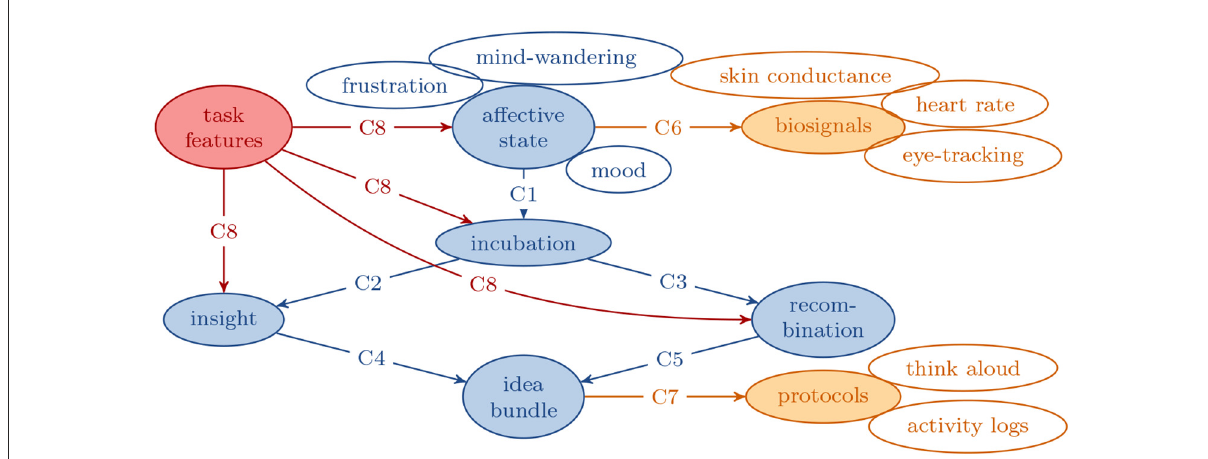
FIGURE4 A closer look at the process plate. The nodes represent different stages of the student cognitive process to generate and validate creative ideas, namely insight, incubation, and recombination, as well as the affective state which influences the process and the idea bundle as result of the process. Citations: C1 (George and Zhou, 2002; Sawyer, 2011; Baird et al., 2012), C2 (Rhodes, 1961; Cropley and Cropley, 2008), C3 (Davidson and Sternberg, 1984; Boden, 1998), C4/C5 (Cropley and Cropley, 2008), C6 (Cooper et al., 2010; Blanchard et al., 2014; Muldner and Burleson,